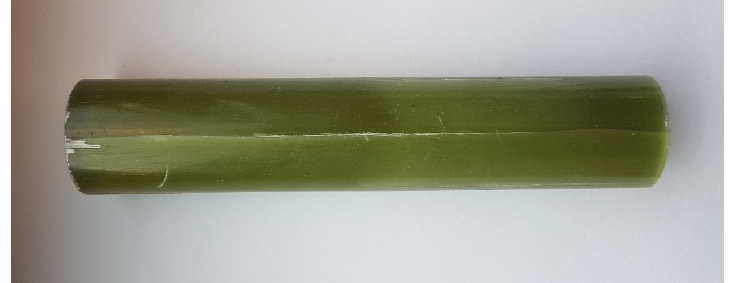
Figure 9. Long axial crack in the lower part of sample C1. Figure 8. Long axial crack on top of sample A1, with an indentation caused by a crosshead of the strength testing machine.